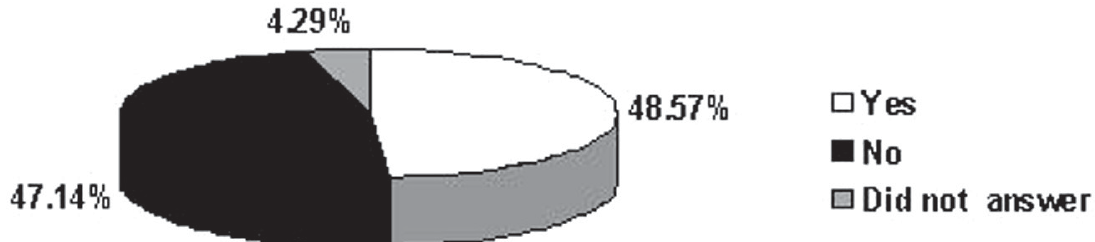
FIGURE 4- Percent distribution of the dentists according to awareness of the penalties imposed in case of breach of confidentiality Andradina/SP,